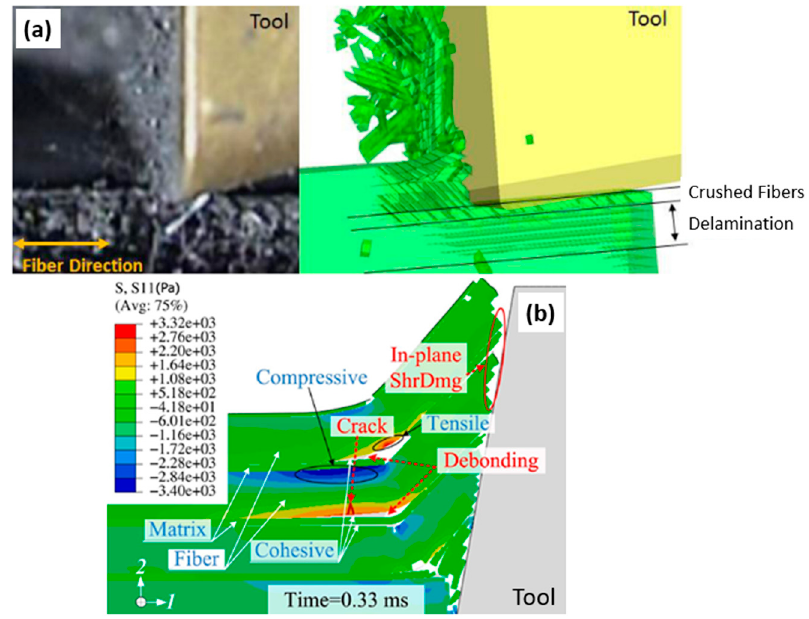
Figure 46. Example of damage cause by machining, (a) Reproduced with Creative Common License [333] Figure46. Exampleofdamagecausebymachining, ( a )ReproducedwithCreativeCommonLicense[333] and (b) Reproduced with permission [334]. and ( b ) Reproduced with permission